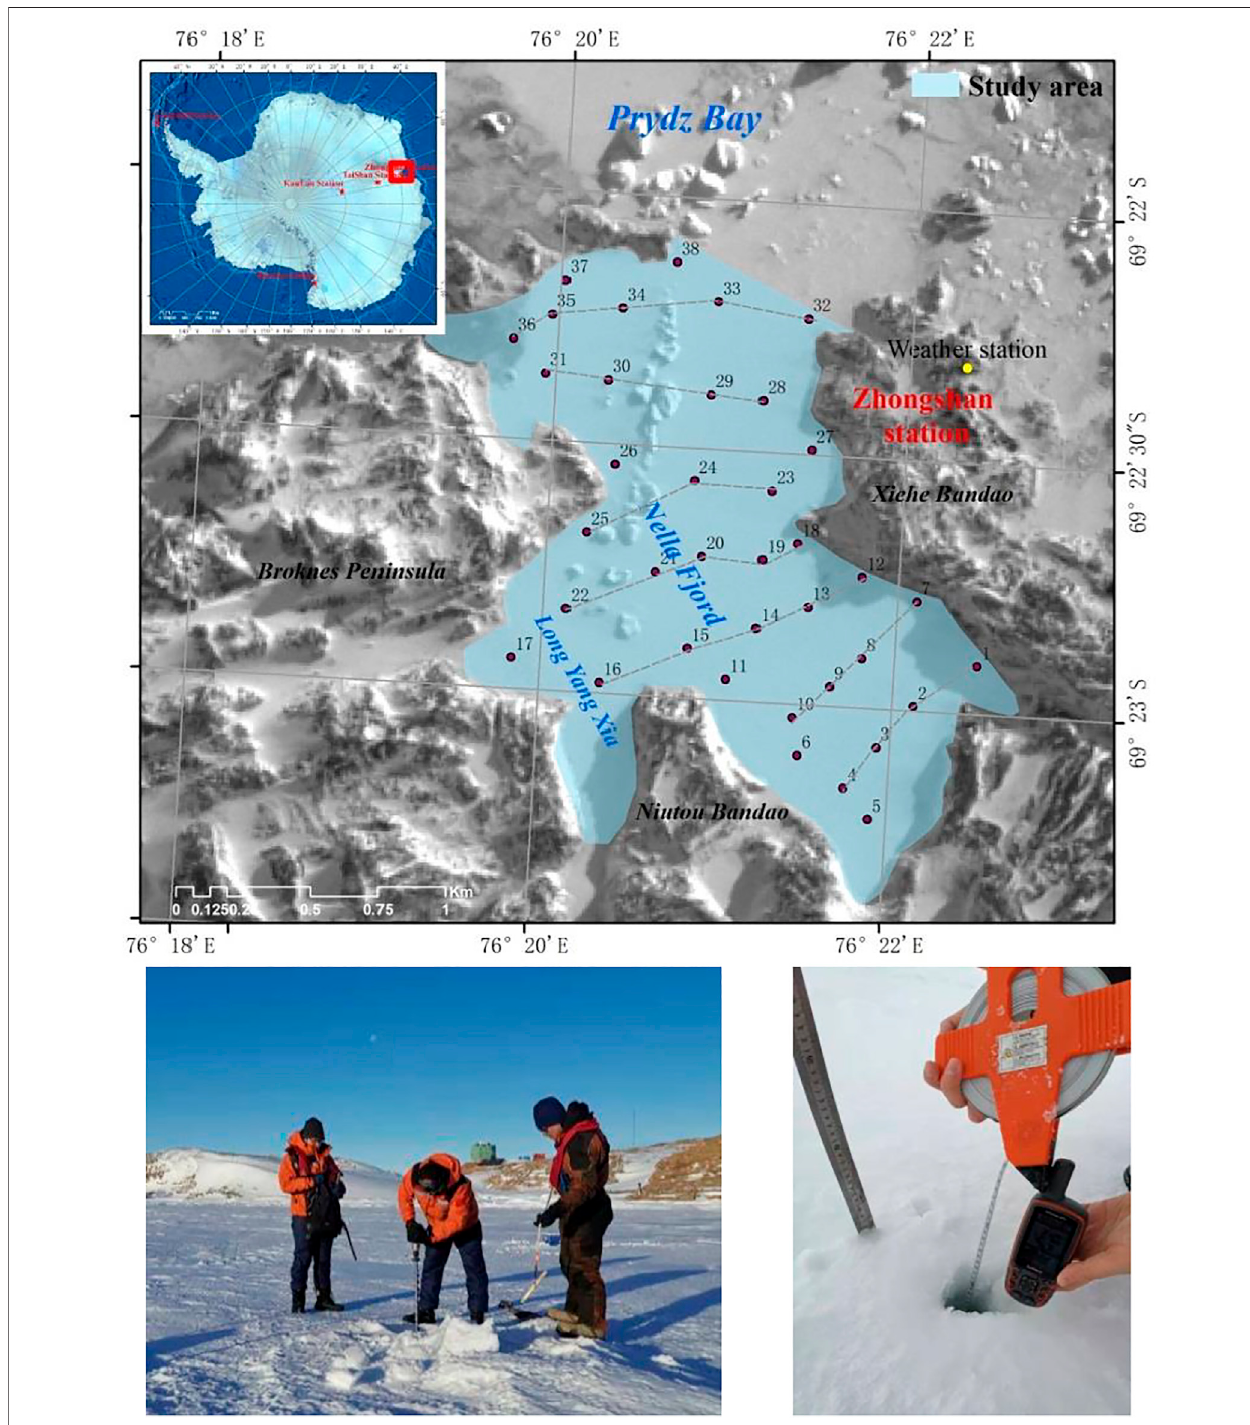
FIGURE 1 | Study area and fi eld observation